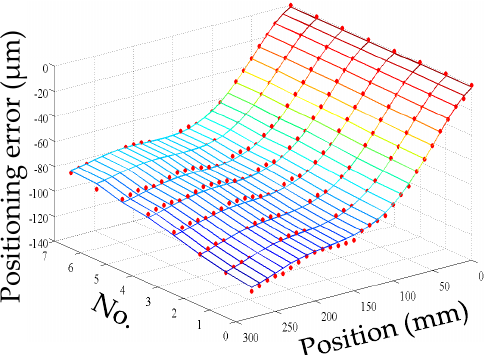
Figure 11. The fitting results of the PCR model (measured positioning error marked with dots) in experiment I.